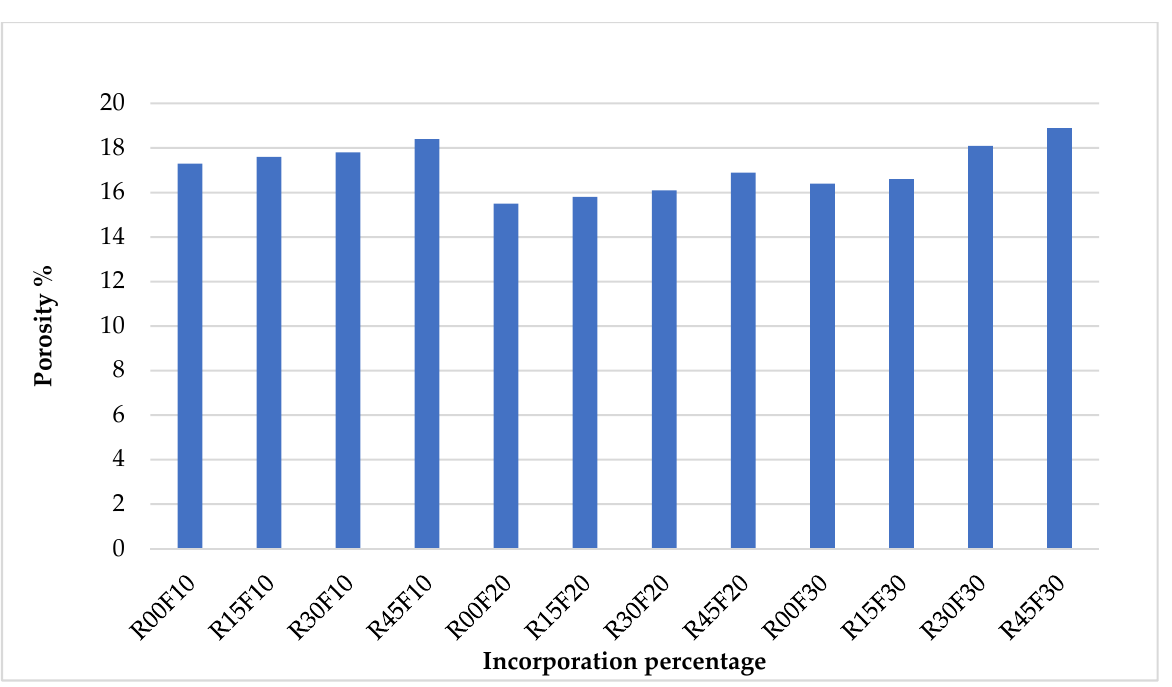
Figure 8. Effect of addition of agro-industrial waste on porosity (R00F10 refers to 0% rice husk and 10% fly ash) [7] .